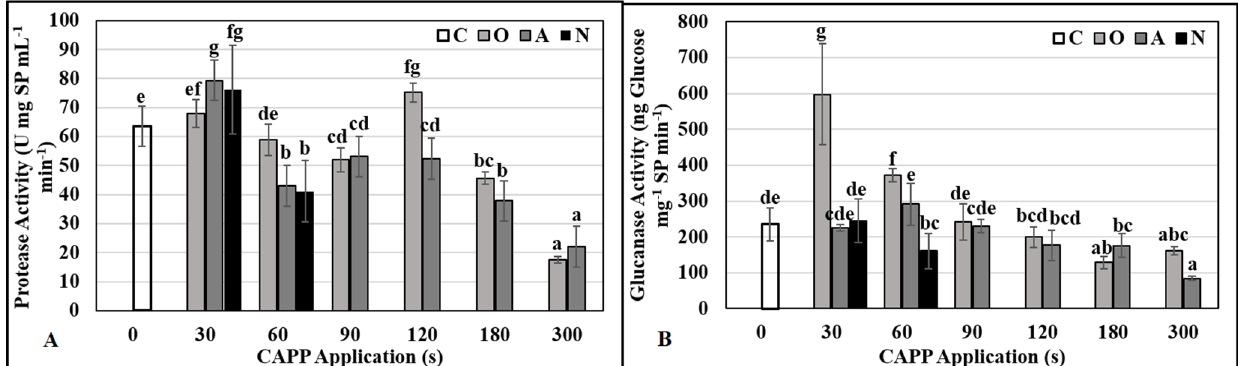
Figure 5. The activity of protease ( A ) and glucanase ( B ) in 3-day-old maize seedlings after Cold Atmospheric Pressure Plasma (CAPP) treatment of grains. Variants: C ‒ control/untreated maize grains; O30 ‒ O300: maize grains treated with plasma generated in an oxygen atmosphere for 30, 60, 90, 120, 180 or 300 s; A30 ‒ A300: maize grains treated with plasma generated in ambient air for 30, 60, 90, 120, 180 or 300 s; N30 ‒ N300: maize grains treated with plasma generated in a nitrogen atmosphere for 30, 60, 90, 120, 180 or 300 s. In the case of N90 variant seedlings lagged significantly in development and in N120 ‒ 300 variants, the maize grains did not germinate, so they are not shown in the graph. Different letters indicate significant difference at p -value < 0.05, bars are means of ten experimental runs (one run represents 50 grains per variant; three 1.5 g mixed samples were analyzed per one experimental run and each variant for protease and glucanase activities) ± SD according to LSD ANOVA test.